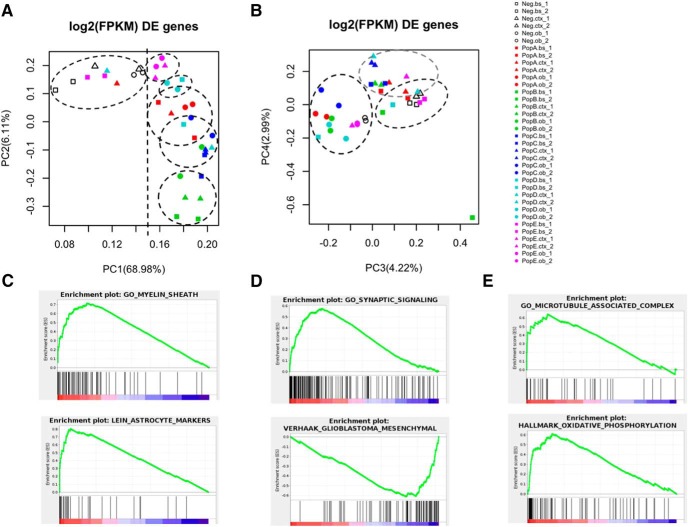
PCA performed using log2-transformed FPKM of 4092 genes DE between regions. A, Scores for PC1 and PC2 are depicted. PC1 separates samples into astrocyte subpopulations and non-astrocyte populations. Circular and elliptical figures enclose samples according to subpopulation. B, The plot of PC3 and PC4 separates samples into brain regions, as indicated by the elliptical figures. C–E, Differentially expressed genes were ranked using the scores of PC1, PC2, and PC3, respectively, and the top enriched gene sets were obtained through GSEA.